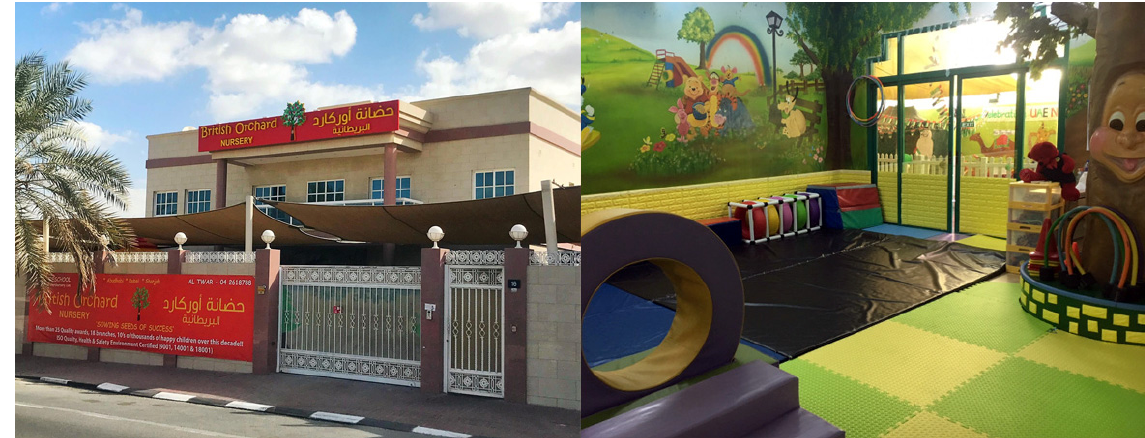
Figure 3. 11 ‐ OR Nursery Exterior and Interior View. Figure 3. 11-OR Nursery Exterior and Interior